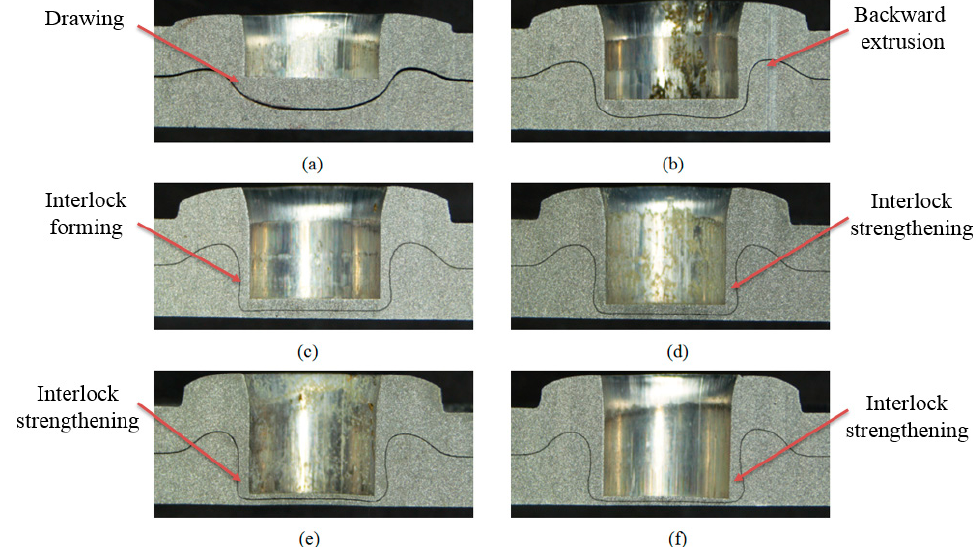
Figure 7. Cross-sectional profiles of joints formed by different forming forces: ( a ) F = 40 kN; ( b ) F = 50 kN; ( c ) F = 60 kN; ( d ) F = 70 kN; ( e ) F = 80 kN; ( f ) F = 90 kN.